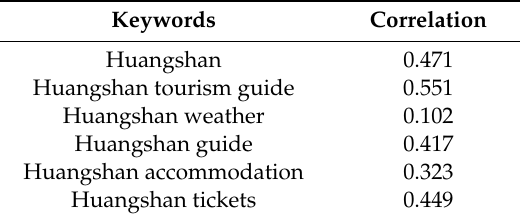
Table 1. Results of correlation